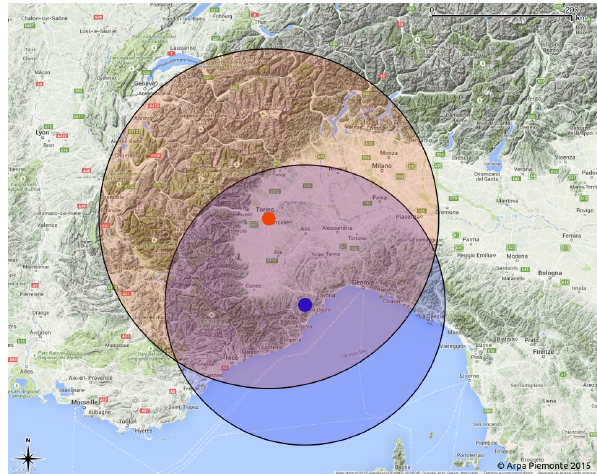
Figure 1. Weather radars in northwestern Italy. The circles corre- spond to the scan domains, and the colors are related to the mark- ers on the map. The red and blue markers represent the two C-band radar locations. The circles represent the Bric della Croce scan (red) and the Monte Settepani scan